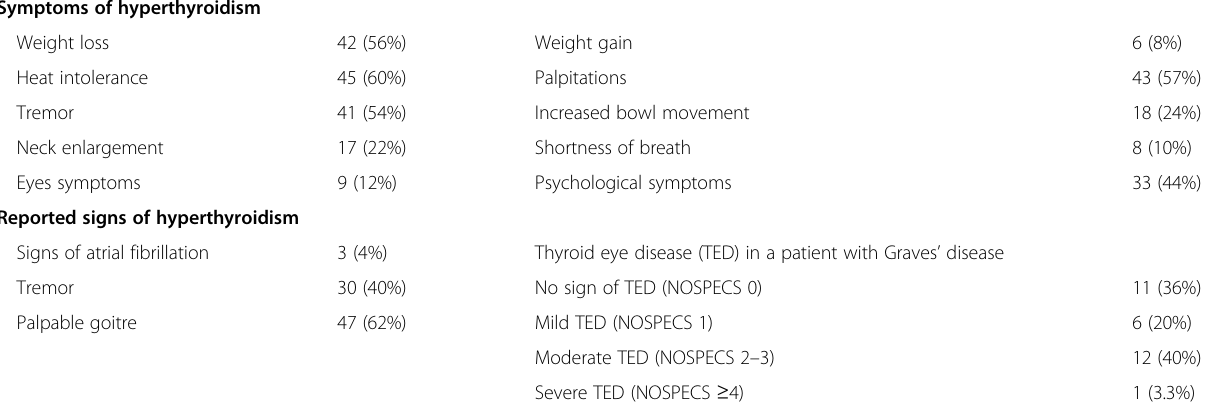
Table 2 Reported symptoms and signs of hyperthyroidism